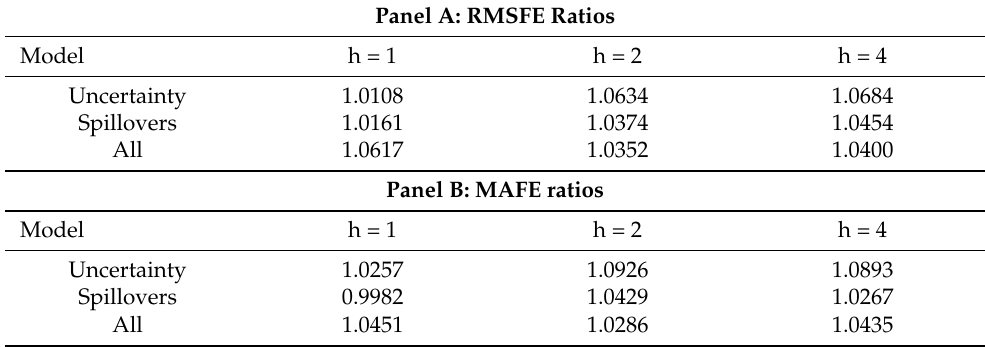
Table 2. Additional forecasting